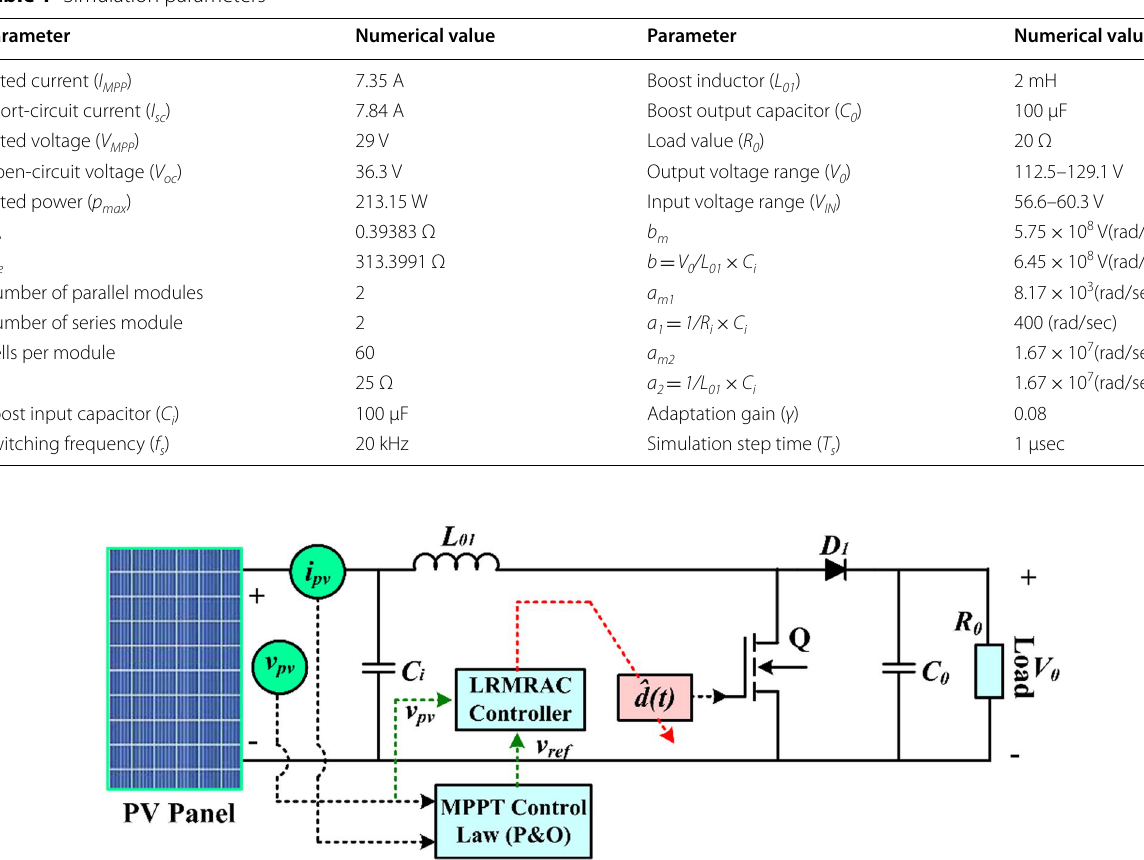
Fig. 9 Representation of the proposed MPPT control architecture for a PV